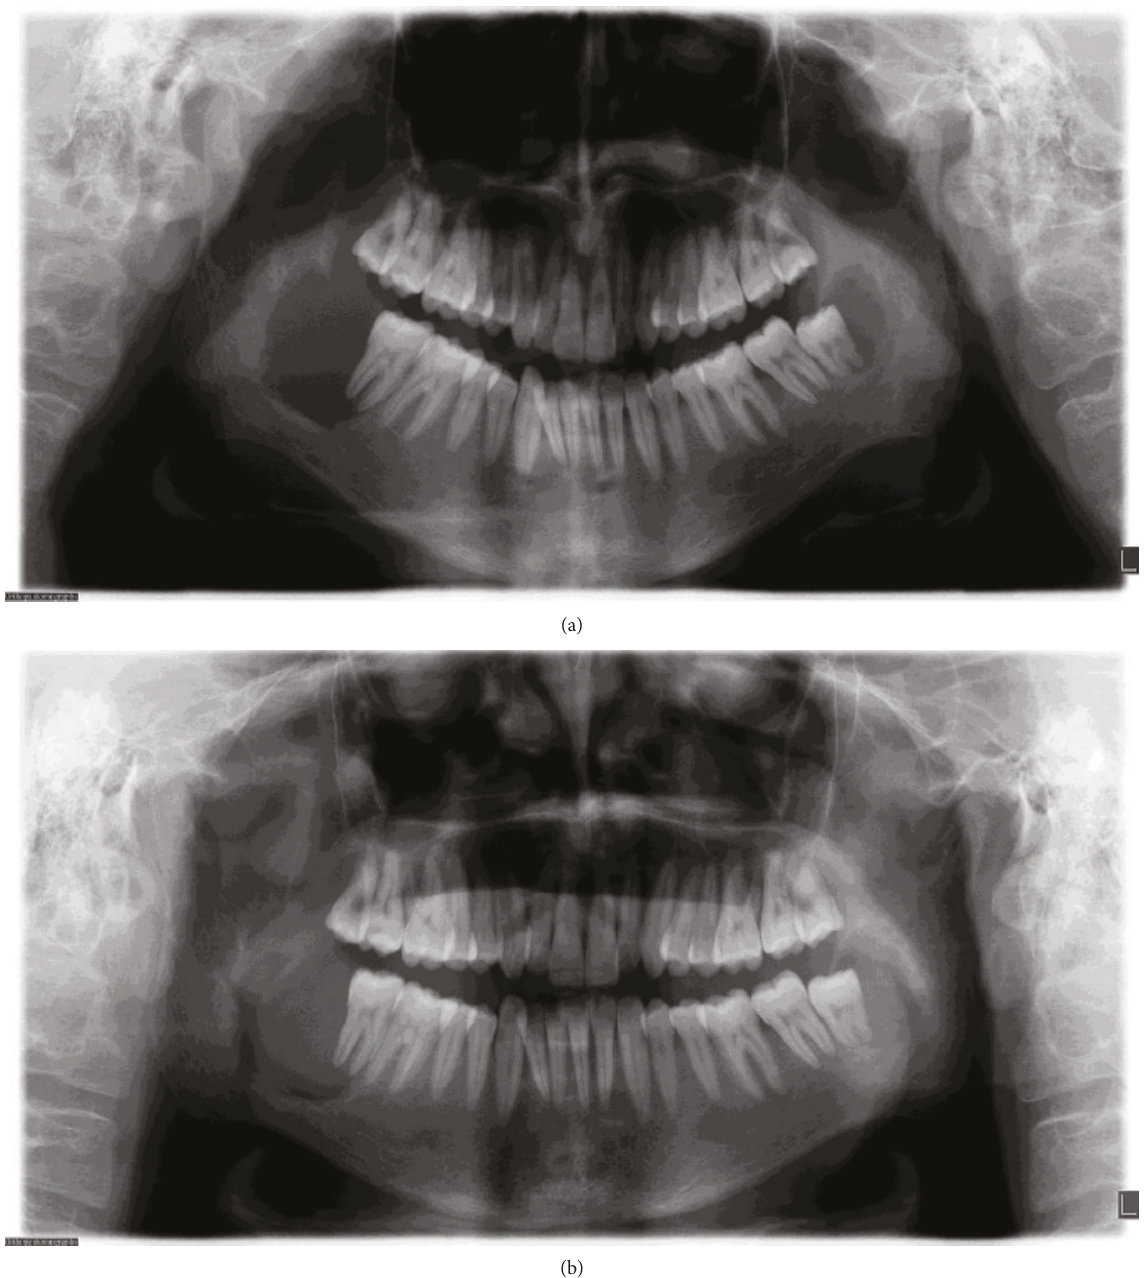
Figure 3: (a) Three months of follow-up: panoramic radiography of bilateral brown tumors. Notice to decreased radiolucency for the brown tumor in the left side of the mandible. (b) First year of follow up: panoramic radiography of bilateral brown tumors. Notice to decreased radiopacity for the brown tumor in the bilateral sides of the